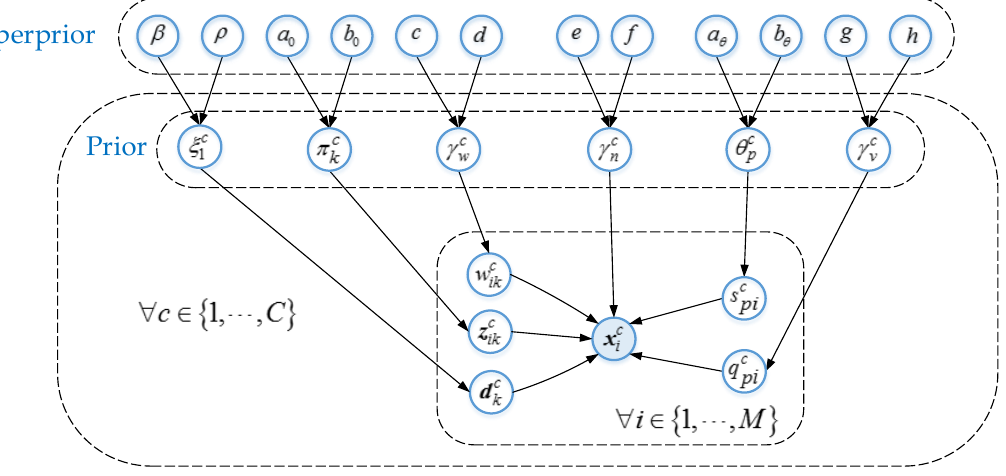
Figure 3. Graphical representation of the hierarchical sparse learning Figure3. Graphical representation of the hierarchical sparse learning model.